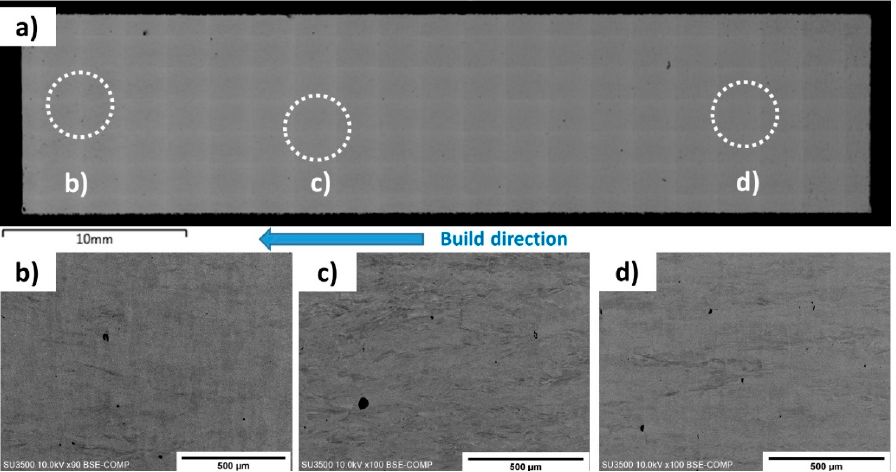
Figure 2 . ( a ) SEM montage of the cylindrical sample and higher magnification images of the ( b ) top, ( c ) middle, and ( d ) bottom of the sample. The regions where ( b – d ) were taken from are highlighted